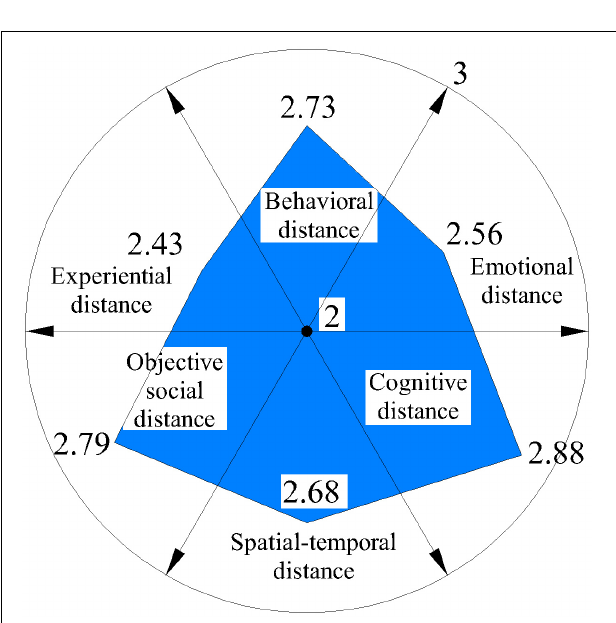
FIGURE 5 | Average psychological distance distribution on existence relationship.